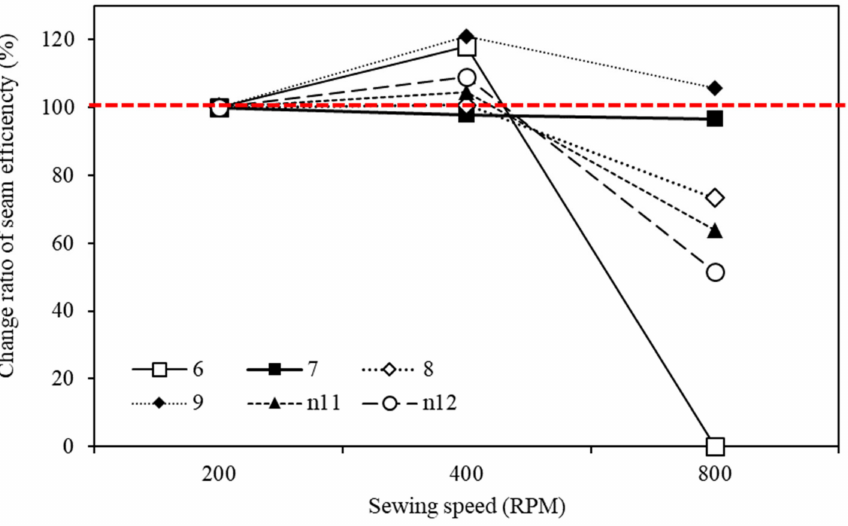
Figure 9. Change ratio of the seam efficiency in the zigzag stitch pattern according to the sewing speed.